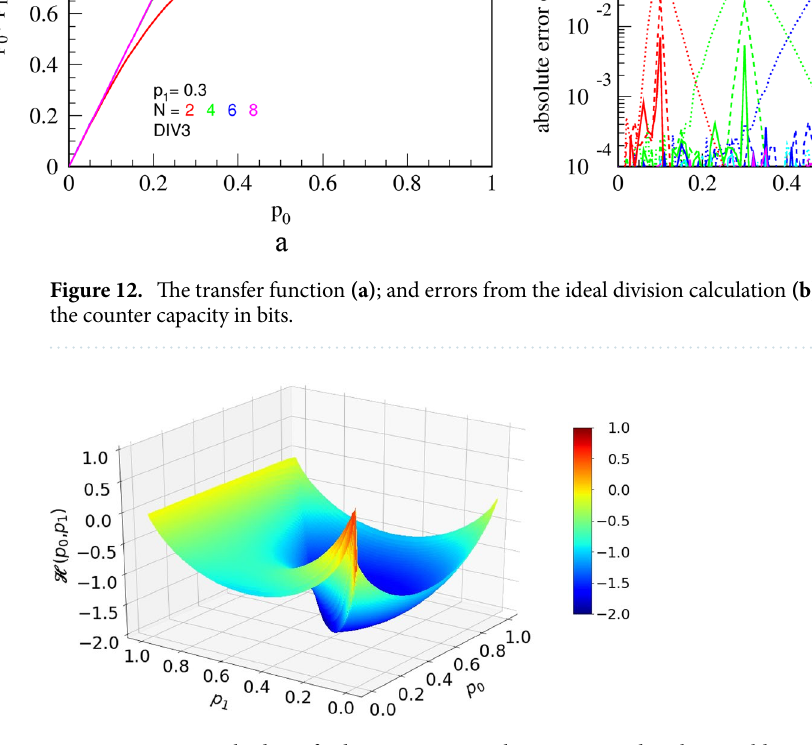
Figure 13. Entropy budget of a division circuit with inputs p 0 and p 1 that would output clipped division p